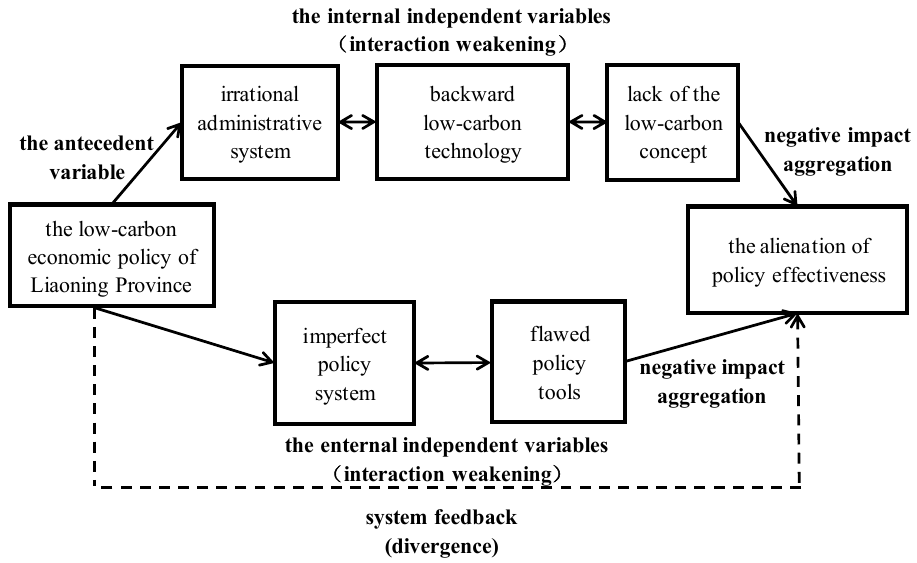
Figure 2. The multi-factor confrontation of policy effectiveness in a low-carbon economy.